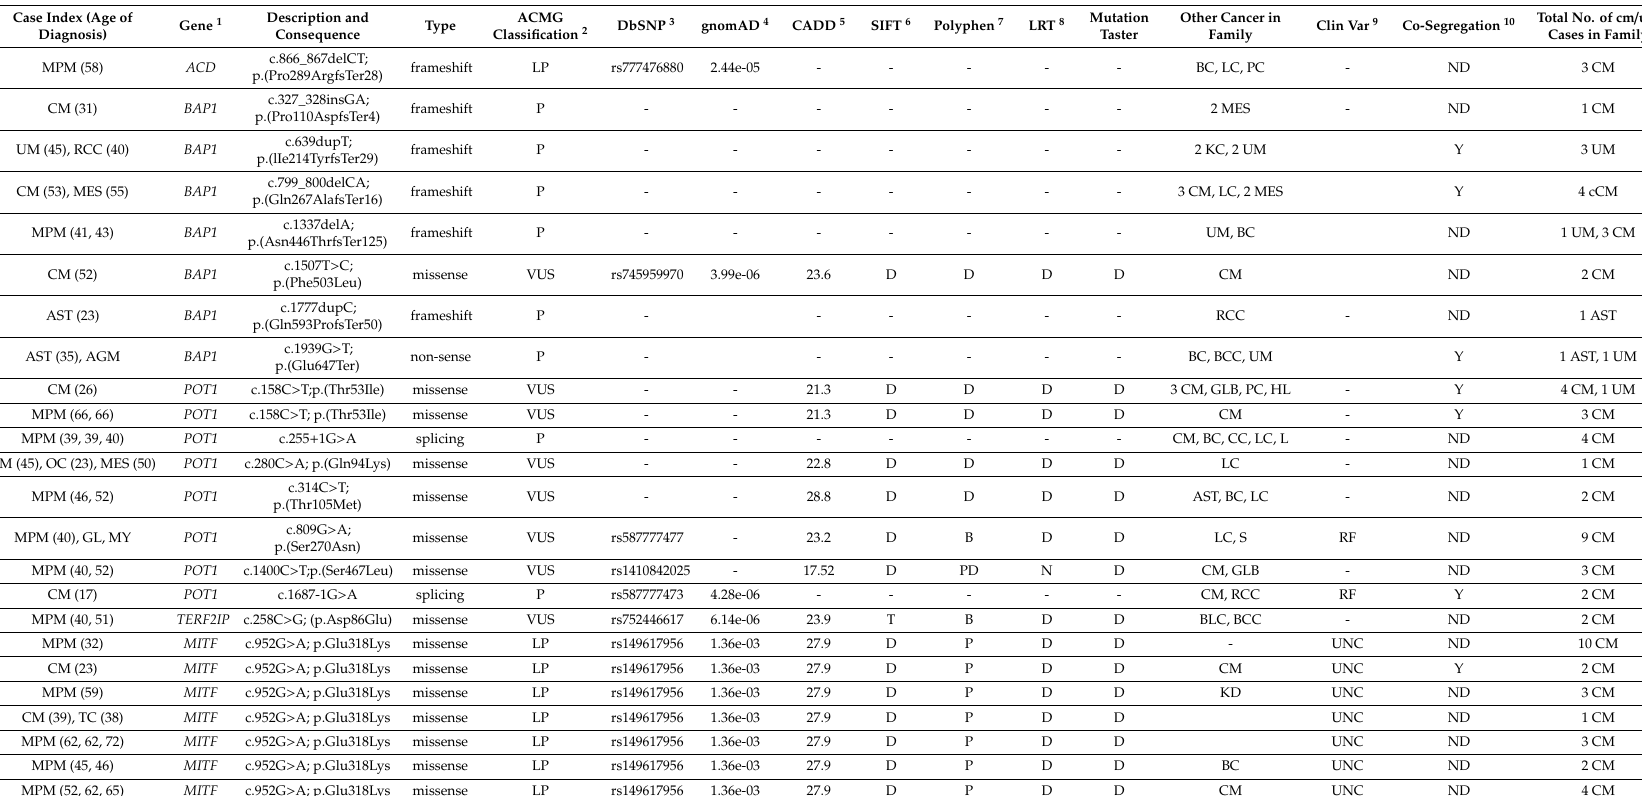
Table 1. Rare variants in melanoma high penetrance genes ACD , BAP1 , POT1 , and TERF2IP and in medium penetrance gene MITF